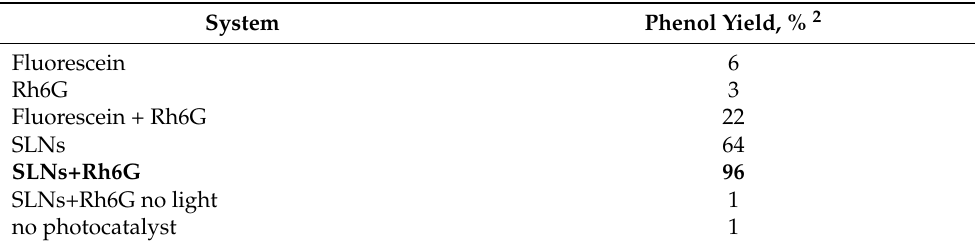
Table 3. HPLS –UV yield of phenol from photoredox hydroxylation of phenylboronic acid using different catalytic systems 1 .